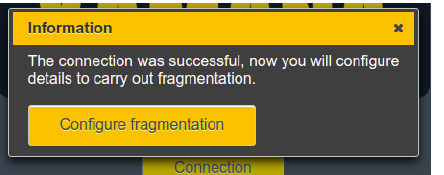
Figure 5. Setting up XAMANA’s remote connection to the user database.